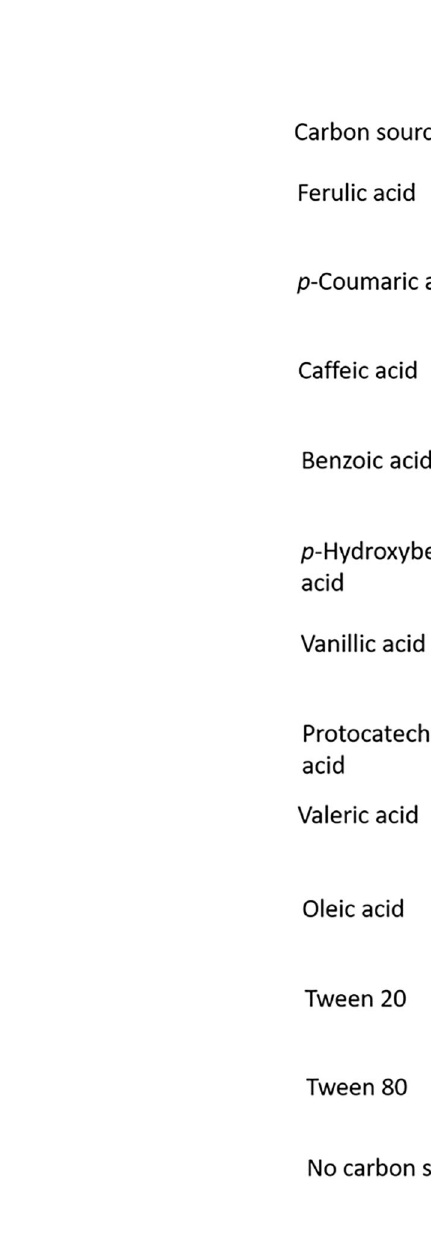
FIGURE 2 Phenotypic analysis of D farA, D farB and D farD mutants. Mutant were grown for seven days on minimal medium with 5mM hydroxycinnamic acids, 5 mM benzoic acid derivatives, 1 mM valeric acid and 5 mM long chain fatty acids. Strain phenotypes were compared to the MA234.1 strains to assess the effects of introduced mutations on carbon source